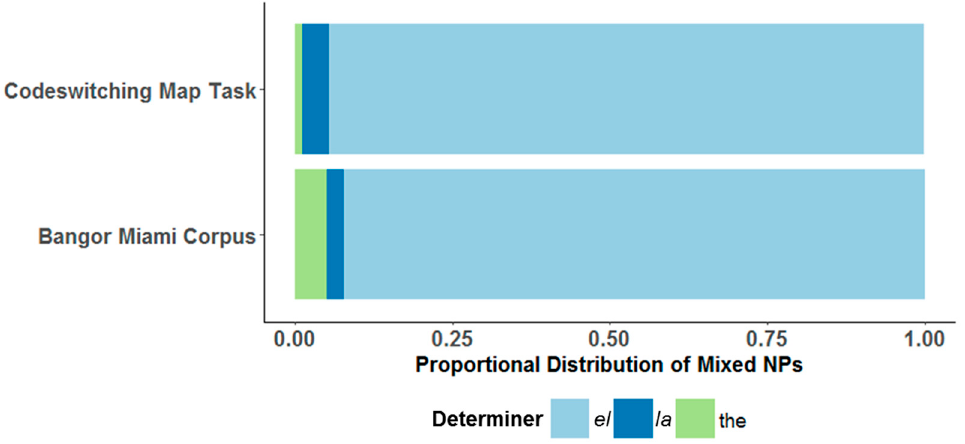
Figure 3. Proportional distribution of mixed NPs produced by codeswitchers in the Codeswitching Map Task and by speakers in the Bangor Miami Corpus.